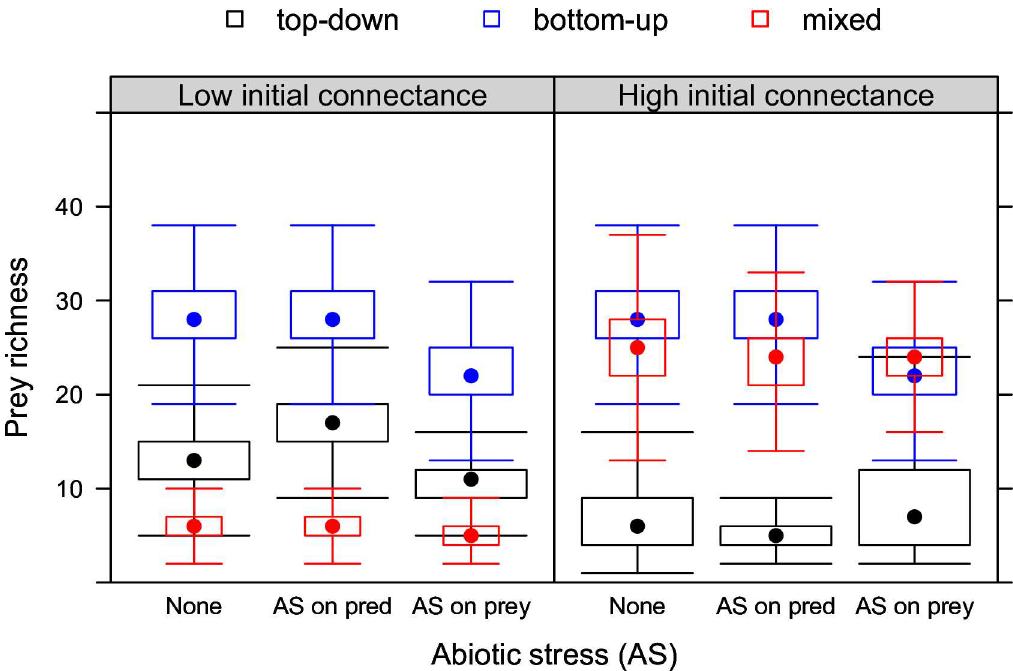
Fig 1. Prey richness under stress. Biotic stress (top-down, bottom-up or mixed control) and abioticstress (none, AS on prey, AS on predators) at low and high initial connectance.